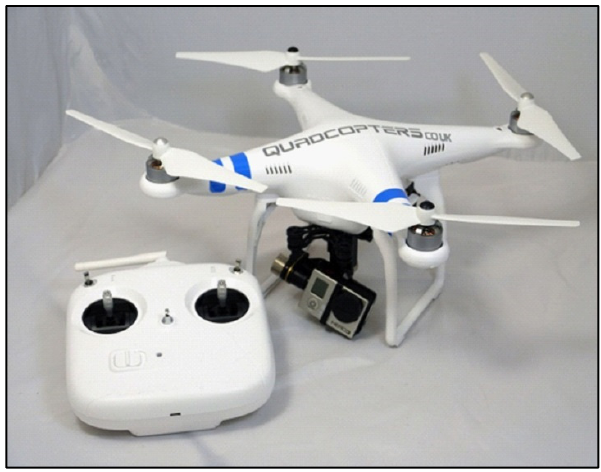
Figure 6. The DJI Phantom 2 unmanned aerial vehicles (UAV) drone equipped with the GoPro camera used in this study.